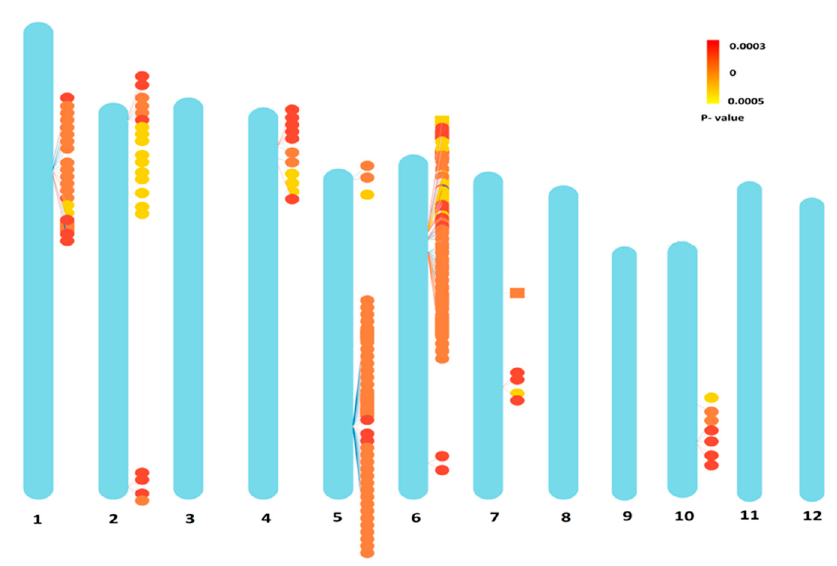
Figure 4. Distribution of significant SNPs on 12 rice chromosomes identified by FarmCPU.